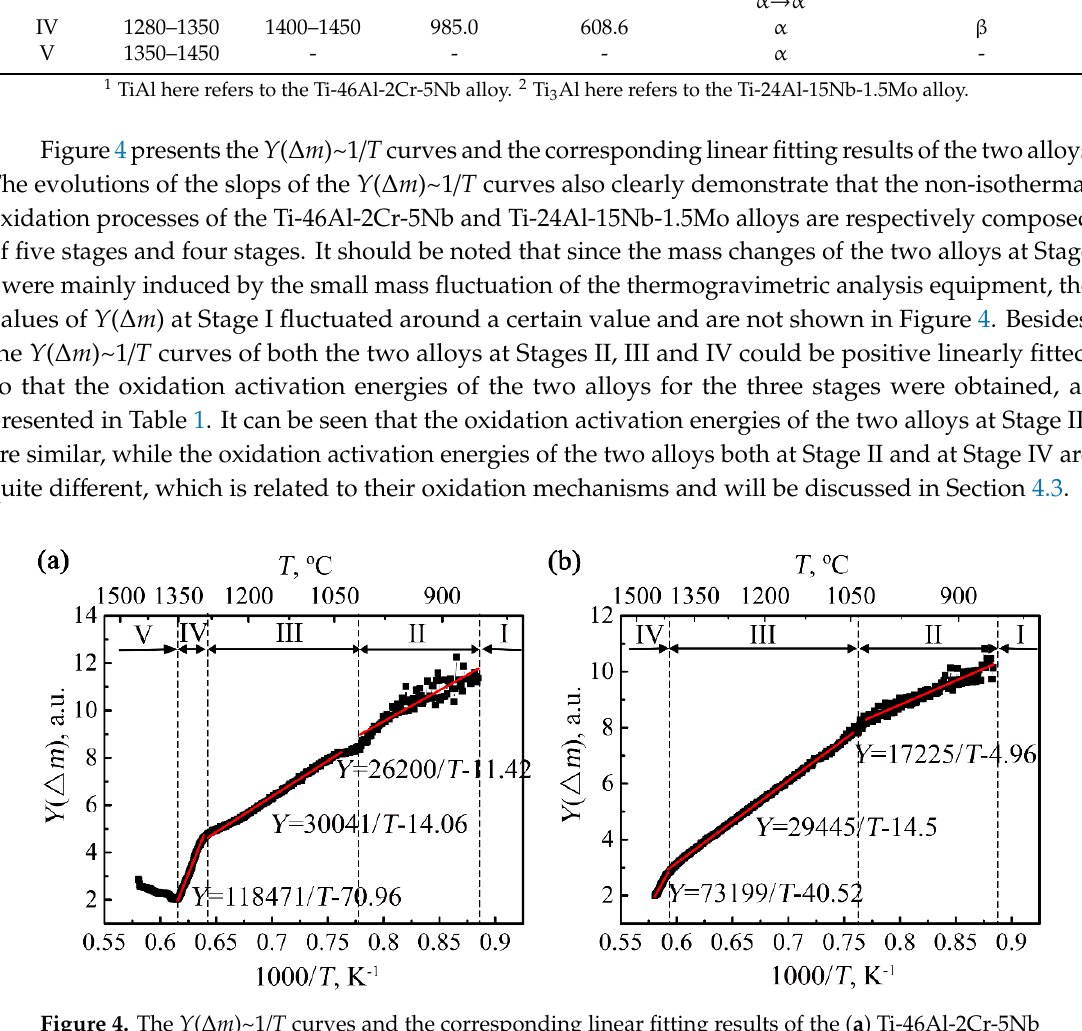
Figure 4. The Y ( ∆ m )~1 / T curves and the corresponding linear fitting results of the ( a ) Ti-46Al-2Cr-5Nb and ( b ) Ti-24Al-15Nb-1.5Mo alloys.